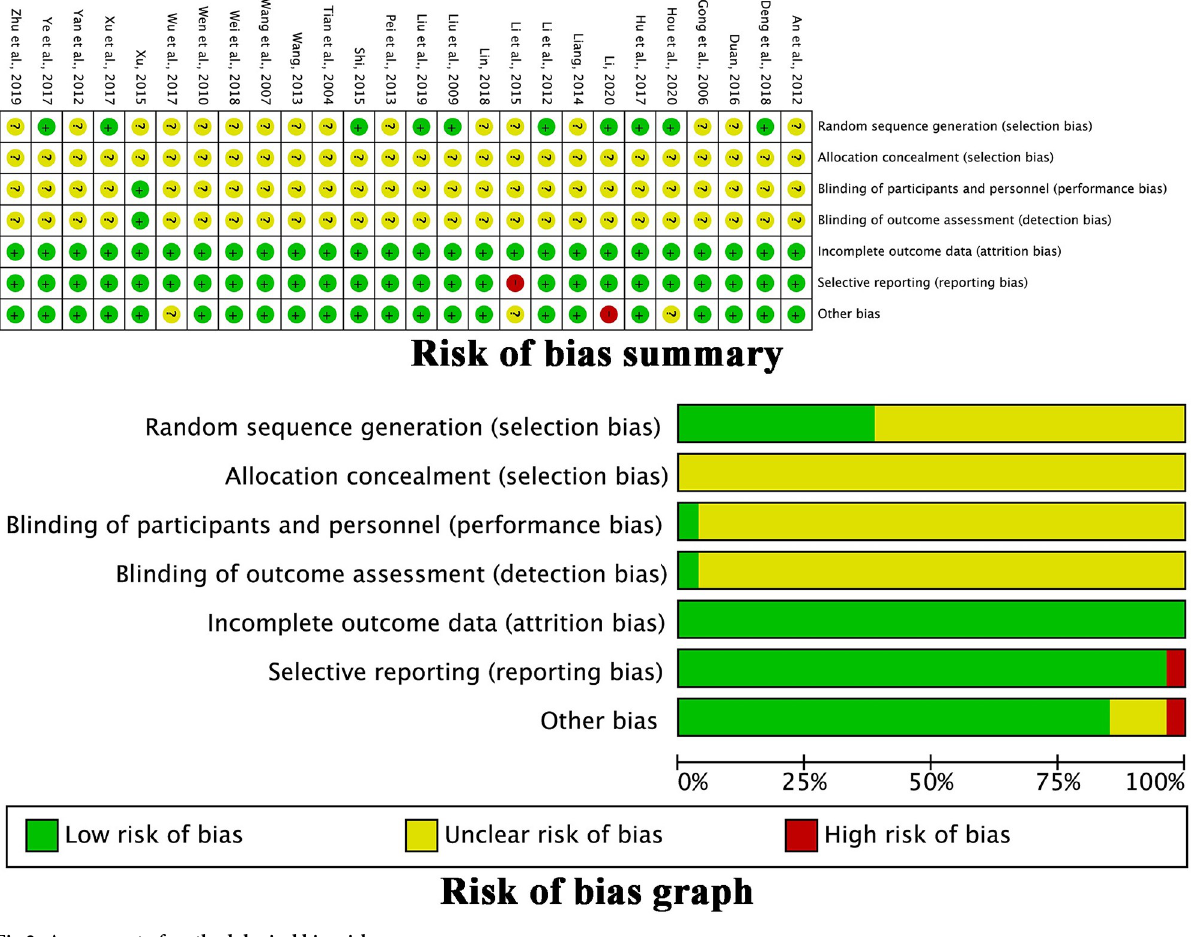
Fig 2. Assessment of methodological bias